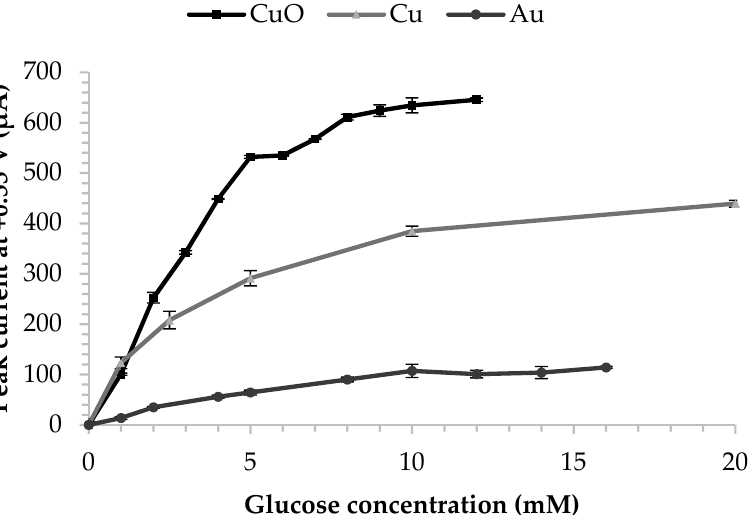
Figure 7. Calibration curve of current response vs. glucose concentration for copper oxide, copper, and commercial gold electrode.